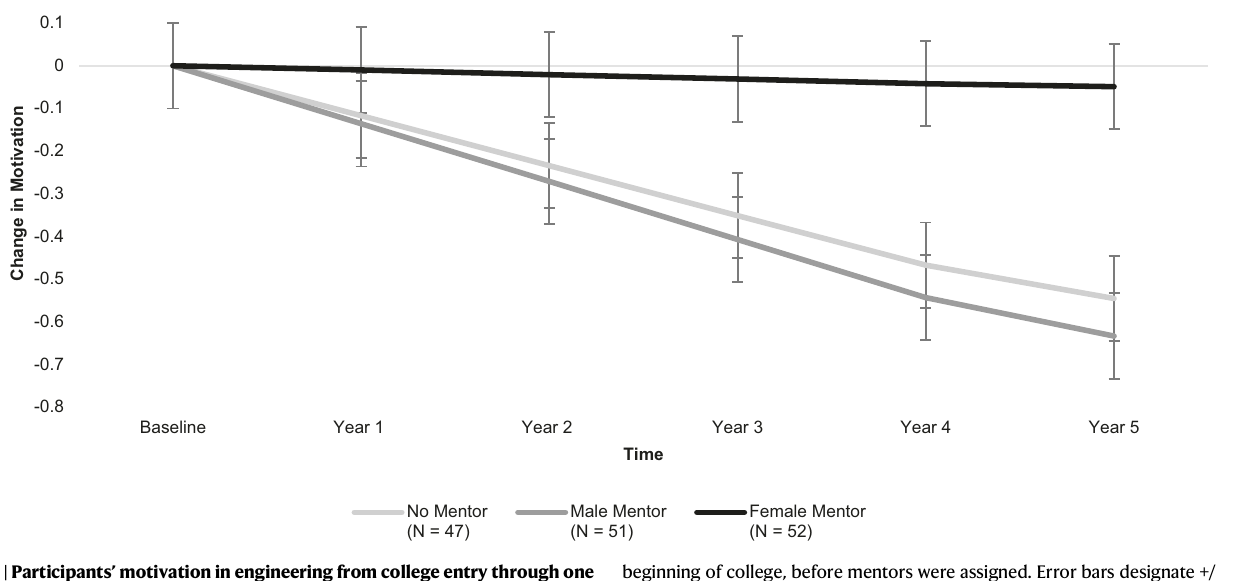
beginning of college, before mentors were assigned. Error bars designate +/ − 1standarderrorofeachcondition ’ sestimatedmeanmotivationlevelsatthattime- point. N =150 participants.